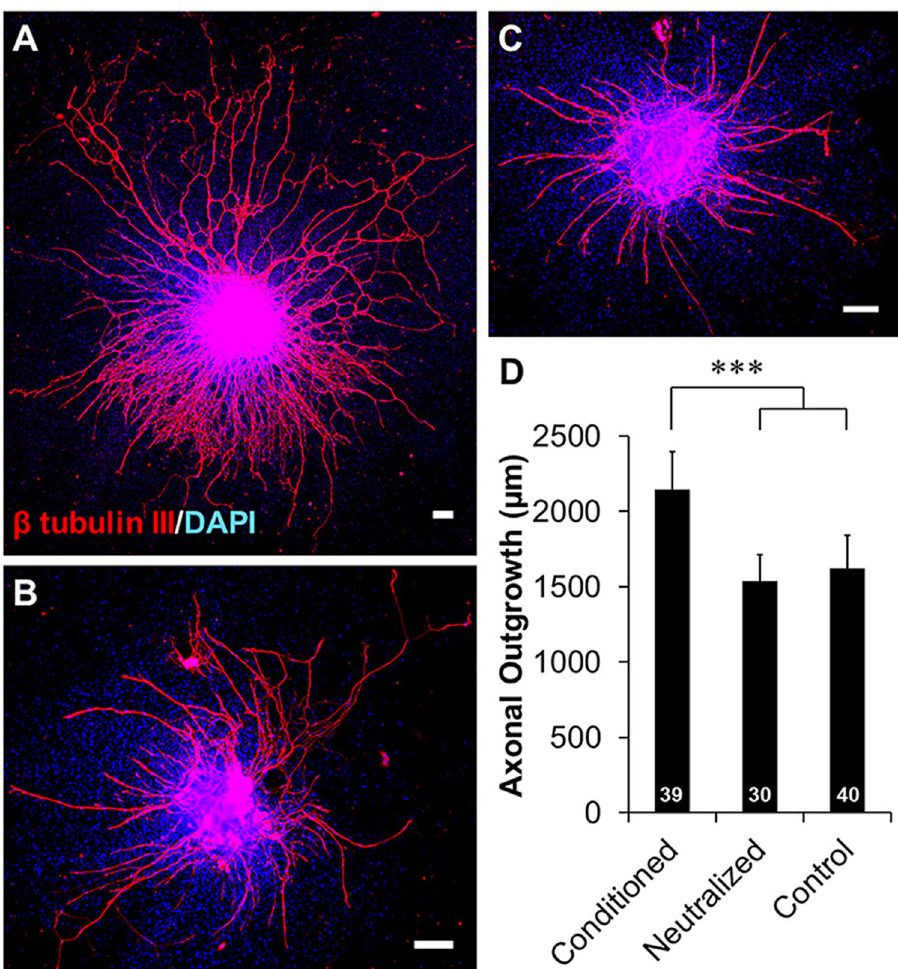
Figure 5. Neutralization of BDNF reduced DRG axonal growth in HUVEC-conditioned medium. DRG explants were cultured on PDL coated wells in ( A ) HUVEC-conditioned medium, ( B ) HUVEC-conditioned medium supplemented with 125 ng/mL of BDNF neutralizing antibody, and ( C ) non-conditioned EGM-2 medium (control). HUVEC-conditioned medium increased the amount of axonal branching from DRG explants. Scale = 200 µ m. ( D ) Quantification of axonal growth between HUVEC-conditioned medium, neutralized conditioned medium, and control. Neutralization of BDNF negated the significant increase of axonal growth observed from conditioned medium. Data are presented as mean ± standard error. *** (p < 0.001) and brackets indicate significance from other treatments as determined by one-way ANOVA with Holm-Sidak post hoc analysis (DRG sample size for each group shown in bars from 3 independent